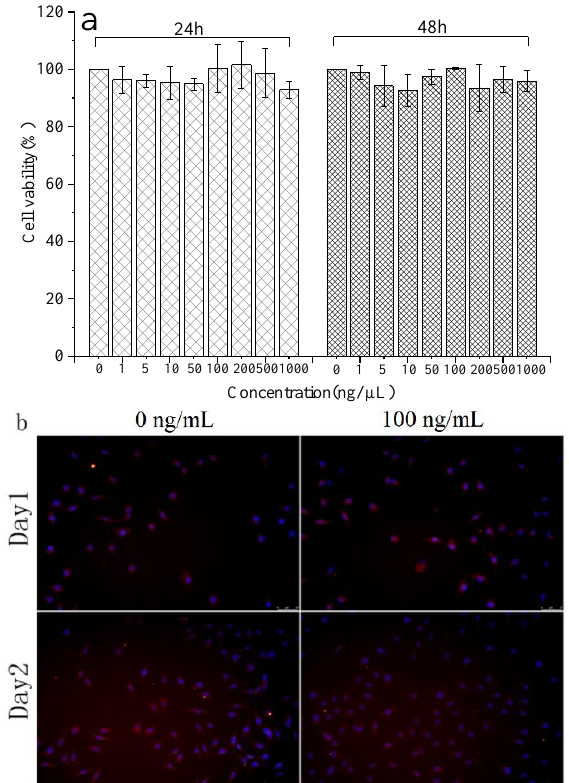
Figure 6. Bioactivities characterization of extracted keratins: ( a ) CCK-8 test, ( b )Fluorescent staining with β -actin/DAPI of L929 mouse fibroblasts with keratin (100 ng/mL) after 1 days and after 2 days of cultivation. The cells were stained for living cells (red) and nuclei (blue). Each group was performed in triplicate and the value was expressed as mean ± variance.